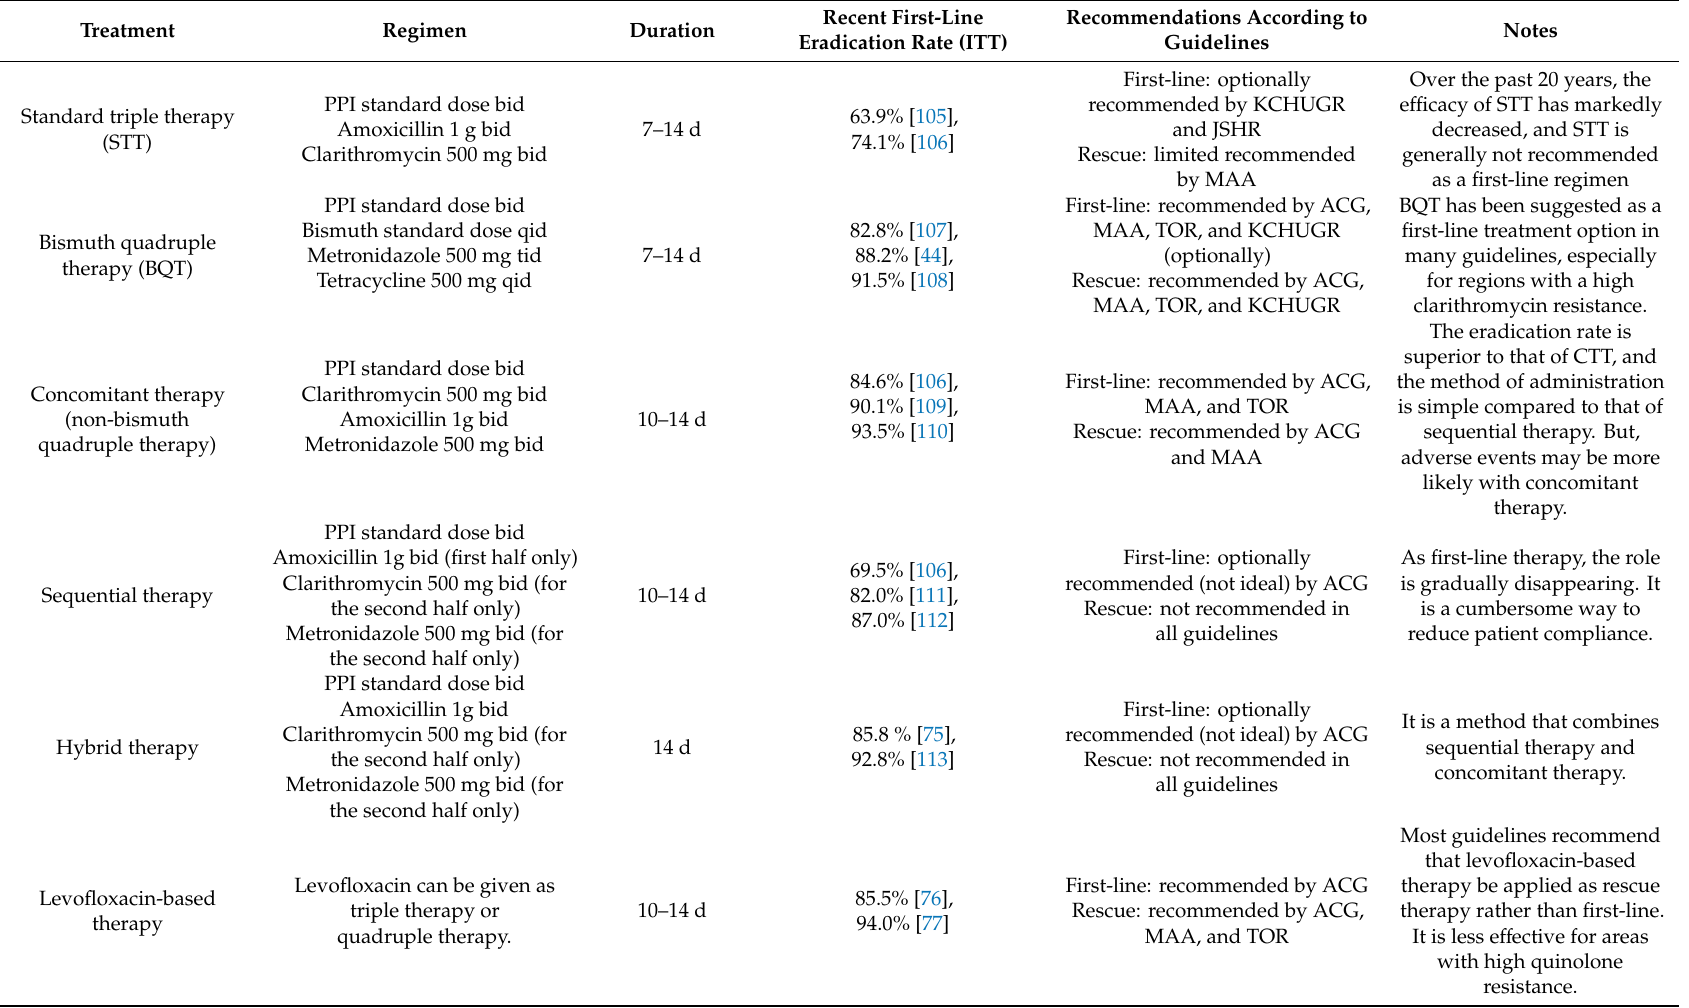
Table 1. Regimens for the treatment of Helicobacter pylori